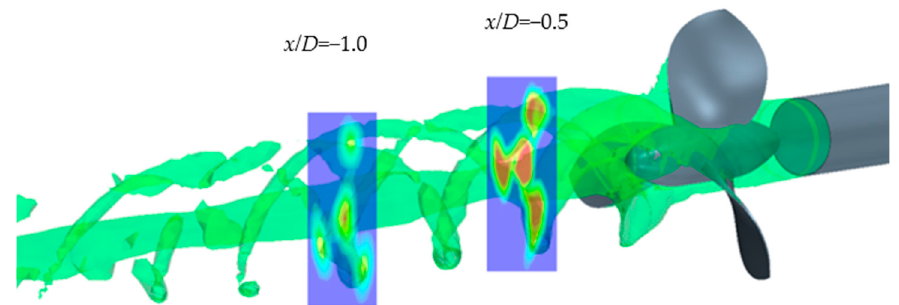
Figure 6. The wake after the ventilated propeller at J = 1.15 when x / D = - 1.0 (left section) and x / D = - 0.5 (right section).